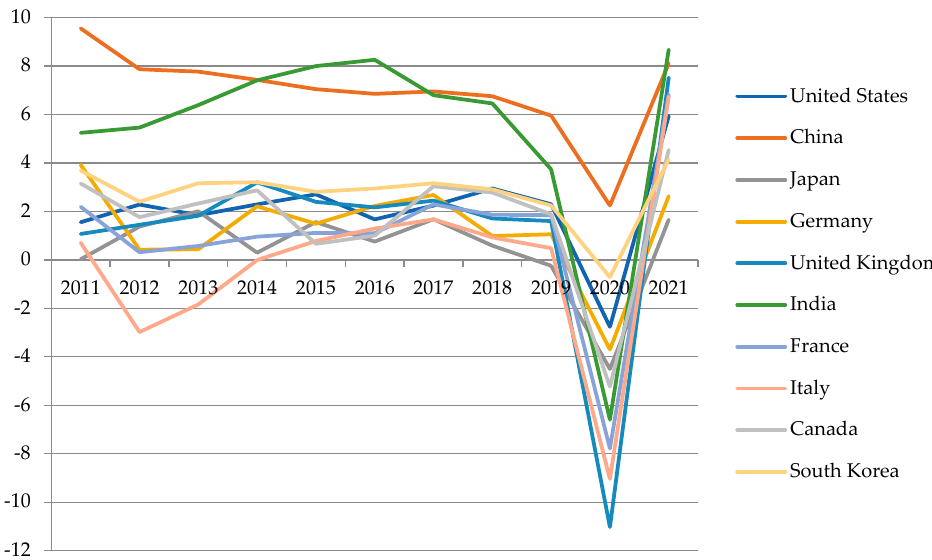
Figure 8. The GDP growth rates (%) for the TOP-10 world economies in 2011–2021.